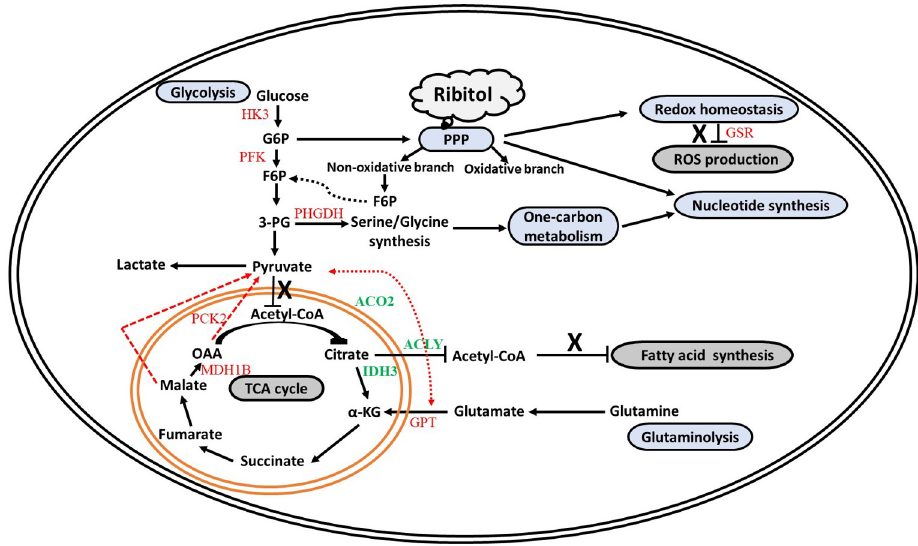
Fig 8. Schematic summary of metabolic and transcriptome alterations in MCF-7 breast cancer cells treated with ribitol. Ribitol treated MCF 7 cells enhances various central carbon metabolic pathways like glycolysis, one carbon metabolism and nucleotide synthesis. Simultaneously, ribitol treatment decreases the ROS production, not entering into the TCA cycle (Acetyl Co-A not assayed in our study) and no fatty acid synthesis further. In addition, some of the TCA cycle intermediates were altered, this could be due to increased glutaminolysis. This may fuel the TCA cycle intermediates and their levels were altered in ribitol treatment. Metabolic pathways and the observed alterations in metabolites are depicted in black, while the associated enzymes found to be altered via transcriptomics are depicted as decreased expression (green) and increased expression (red) upon ribitol administration.